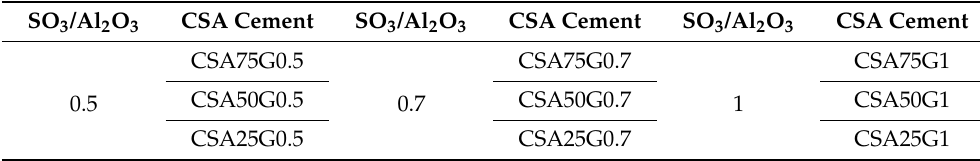
Table 2. References of synthetized CSA cement with different SO 3/ Al 2 O 3